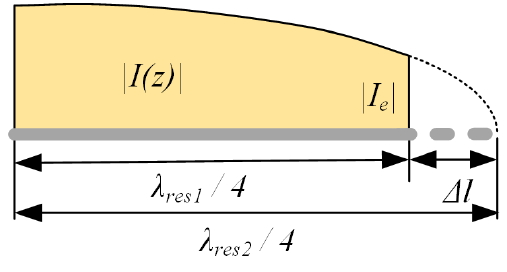
Figure 5. A capacitive load leads to an extension of the electrical length of the resonator.